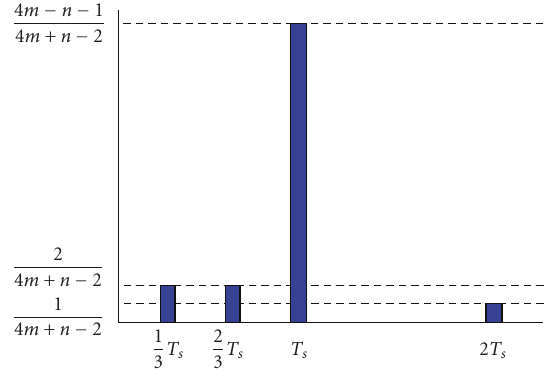
Figure 2: Components of a BOC(5,3) signal in the time-domain. The vertical solid indicators displayed over the code correspond to the subcarrier phase jumps, whereas the dashed indicators in the PRN code correspond to the possible transitions in the code state.